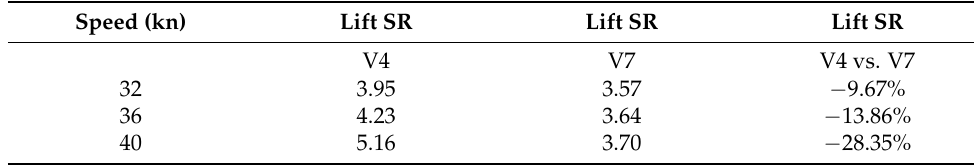
Table 17. Comparison of lift computed on